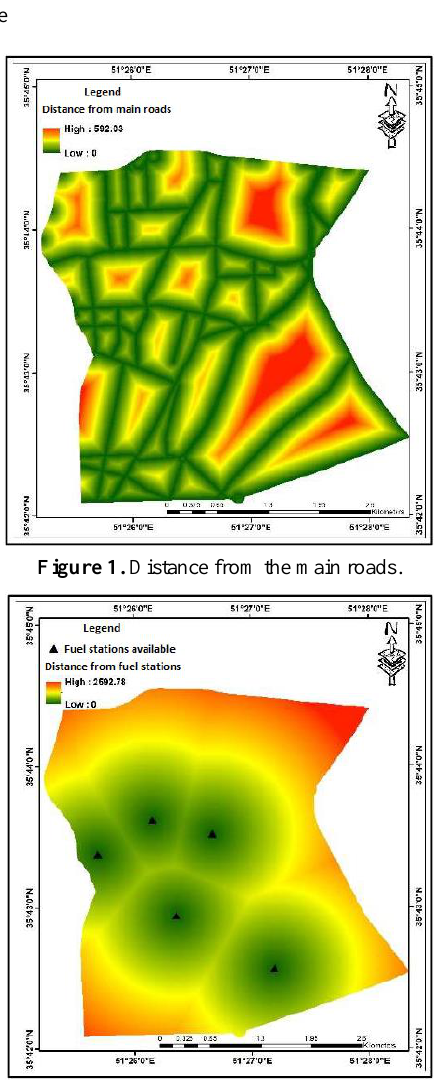
Figure 2. Distance from existing fuel